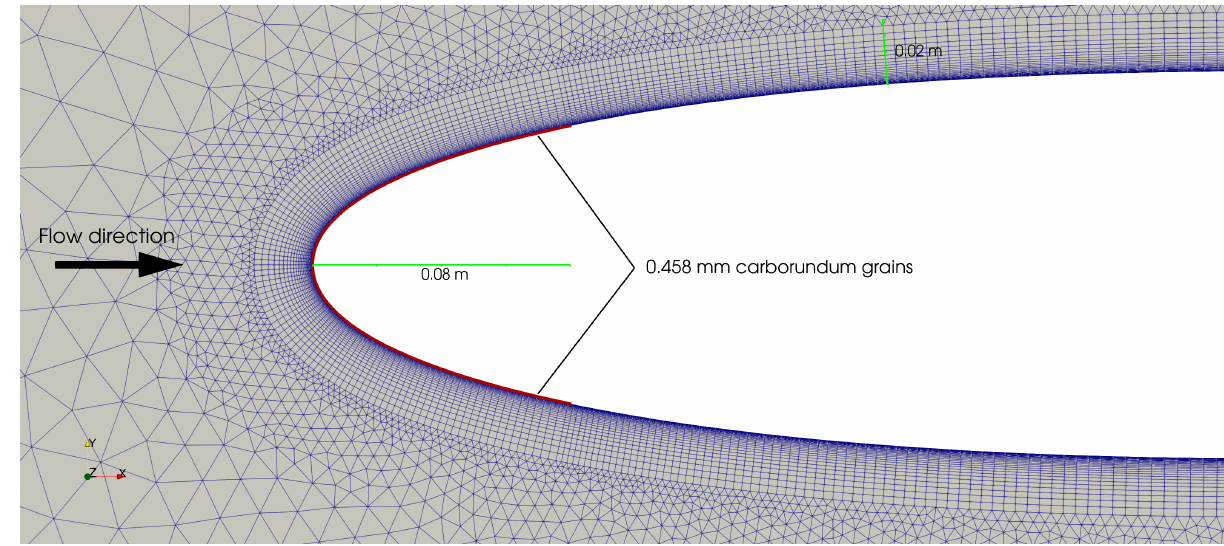
Figure 3. Medium mesh close to the leading area for the NACA 0012. When activated, the rough surface covers the first 0.08 c